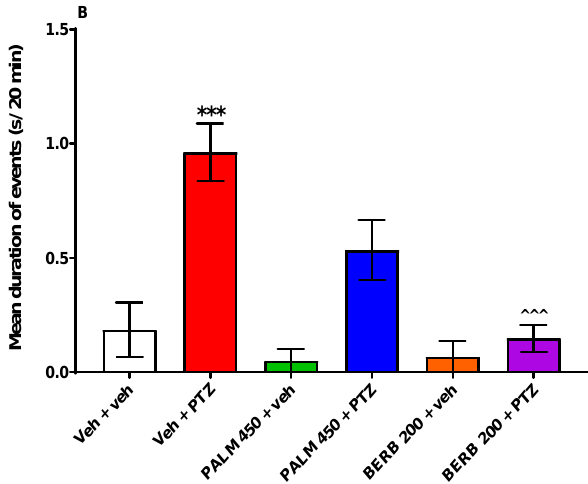
Figure 3. Electroencephalographic (EEG) recordings obtained from the optic tectum of 7 dpf zebrafish larvae pre-incubated for 24 h with PALM (450 µM) or BERB (200 µM). Data are shown as ( A ) number of events (nr/20 min) and ( B ) mean duration of events (s/20 min). Data were analyzed using one-way